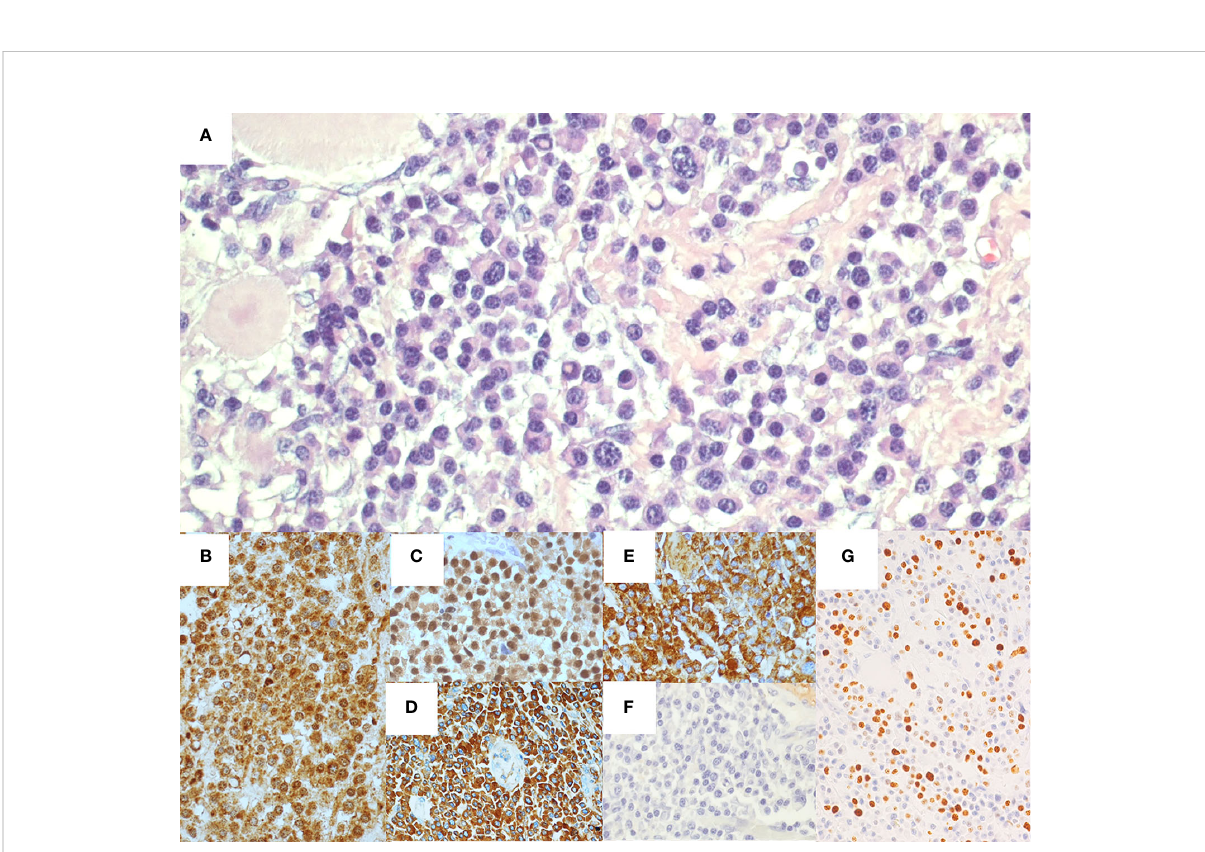
FIGURE 2 Histological and immunohistochemical features of ileal resection specimen. Hematoxylin-eosin staining (A) shows ileal wall in fi ltrated by a proliferation of pleomorphic plasma cells. Immunohistochemical staining presented CD138 + (B) , MUM1 + (C) , IgA + (D) , and monoclonal restriction for Kappa light chain of Ig (E) , whereas Lambda light chains of Ig tested negative (F) . The proliferative index (Mib1/Ki67) was around 40% (G)